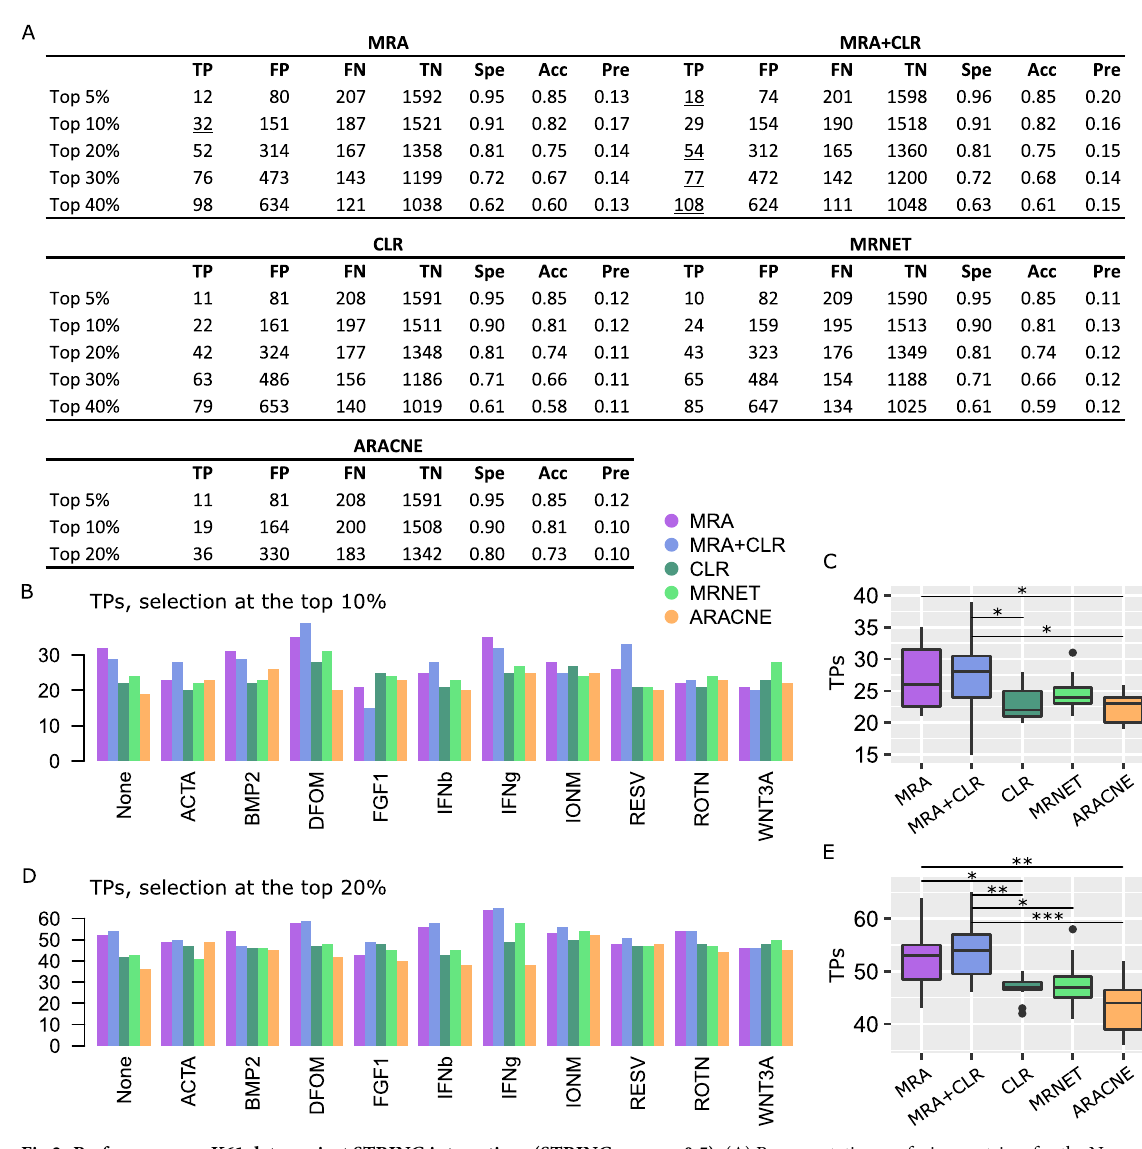
influences of JAK1 on its targets compared to JAK2 and TYR2 (first three columns), which already indicate different signal transduction capabilities. Upon IFNb stimulation, the interac- tions are closer with opposed action on ROR1 and PDFGRA. JAK2 and TYR2 remained highly similar in this condition. IFNg stimulation induced three different patterns with ROR1 tran- scriptional inhibition remaining a specific mark of JAK1. Gapp et al . also found differences in FGF receptors. FGF-induced response was attenuated in FGFR1 and FGFR3 KO cells, but pre- served in FGFR2 and FGFR4 KO cells. In Fig 3B, we notice an almost perfect inversion of the activation/inhibition pattern between FGFR1 versus FGFR2 and FGFR3. FGFR4 adopted a